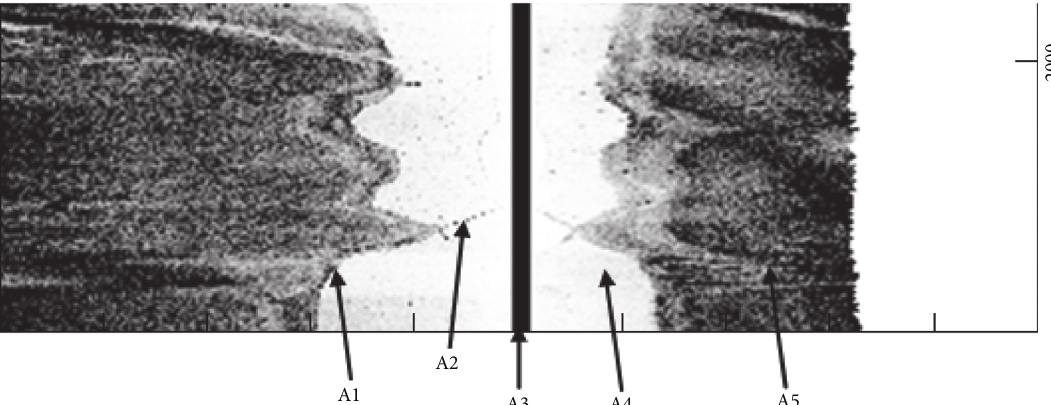
Figure 5: Main distribution parameters of the SSS waterfall image.